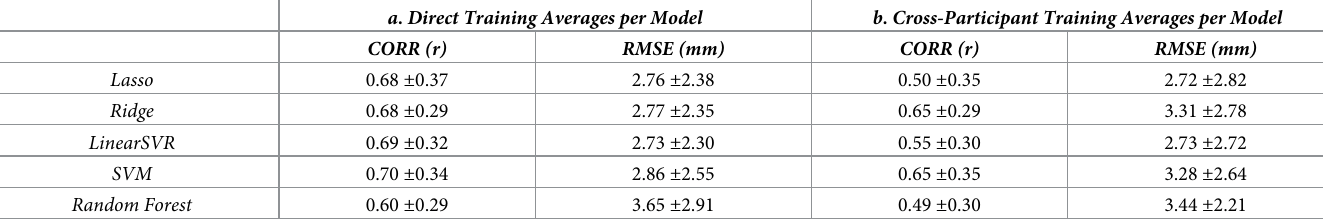
Table 1. Machine learning (ML) model